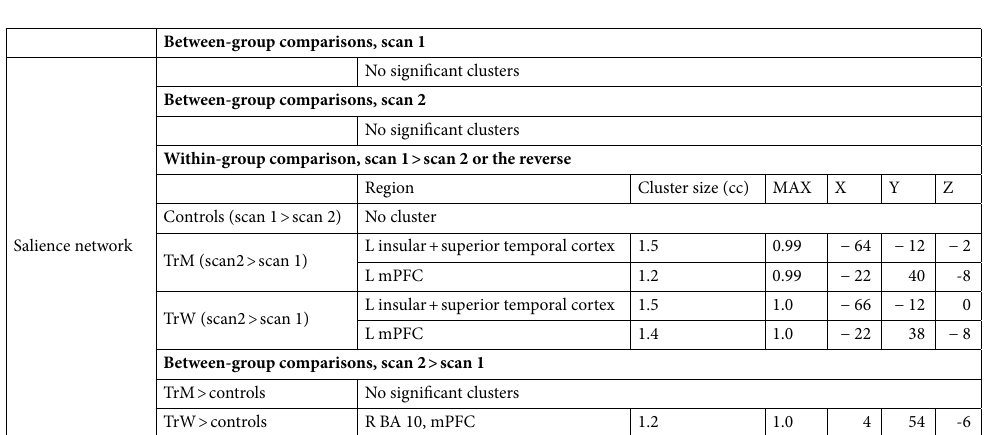
Figure 2. Significant group differences in rs-fMRI within the default mode network (DMN). Differences at scan 1 are shown to the left in the image. Group differences in scan2-scan1 changes are shown to the right in the image. Differences between controls and transmen are indicated in blue. Differences between controls and transwomen are indicated in red. Overlapping clusters are indicated in purple. All clusters are calculated at p < 0.0083, corrected (minimum cluster size 1.0 cc). MNI coordinates for the crosshair are 4, − 16, 2.